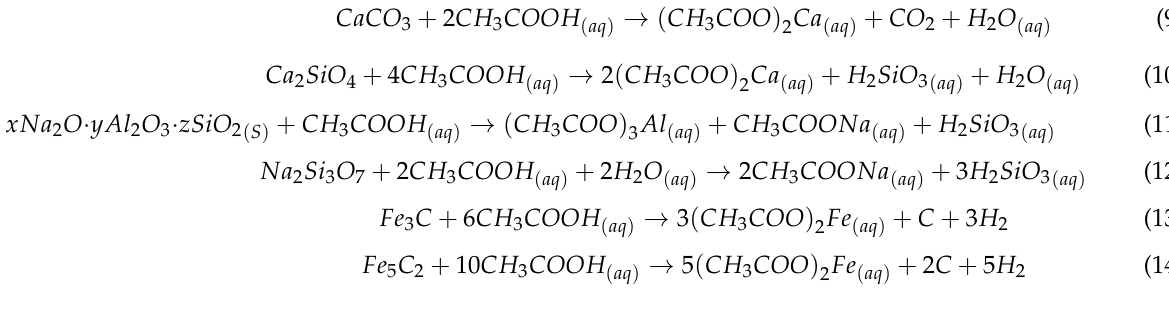
Figure 12. Effect of acetic acid concentration on the acid leaching concentrate (carburized at 700 °C for 150 min with 20% Na 2 SO 4 ; leached at 70 °C for 60 min).